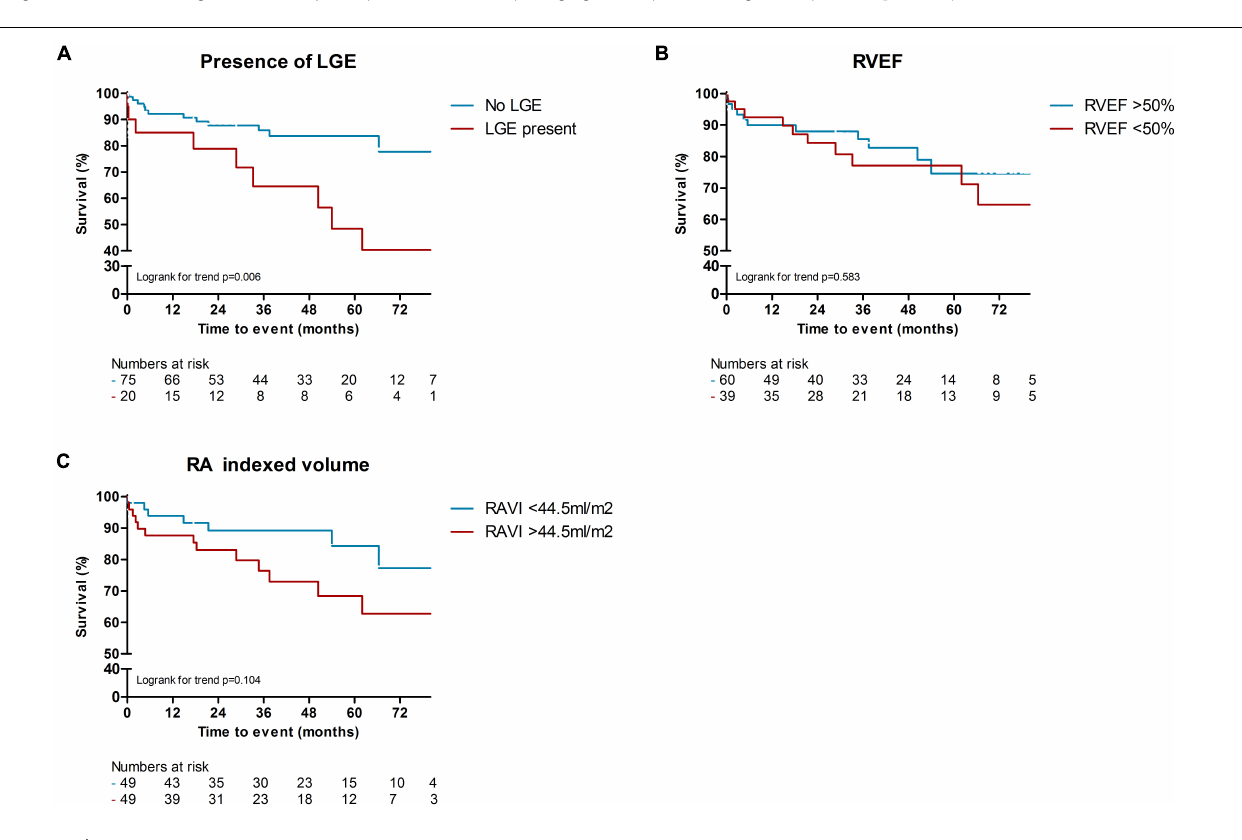
associated with differences in all-cause mortality ( p = 0.852, Figure 3D